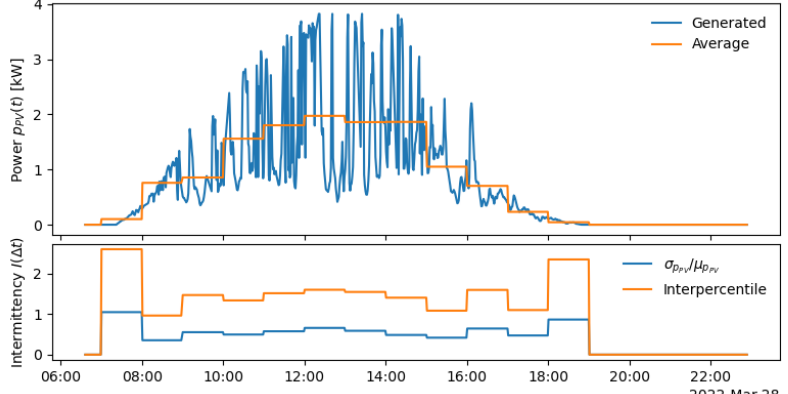
Figure 24. Quantified intermittency according to Equations (2) and (3).